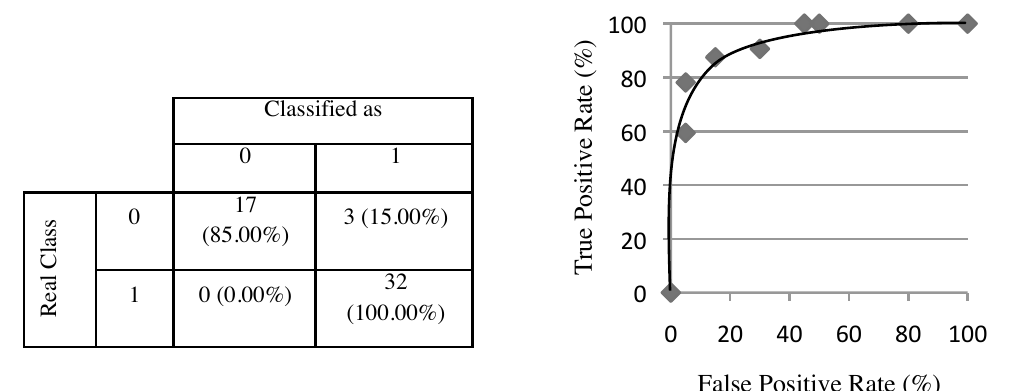
Figure 4: (Left): Confusion matrix for meta-profiles classification (with penalty = 61.4%). (Right): Approximate ROC curve constructed with variations of the penalty in the sum criterion for meta- profiles classification. Class 0 and 1 correspond to bad and good responders,